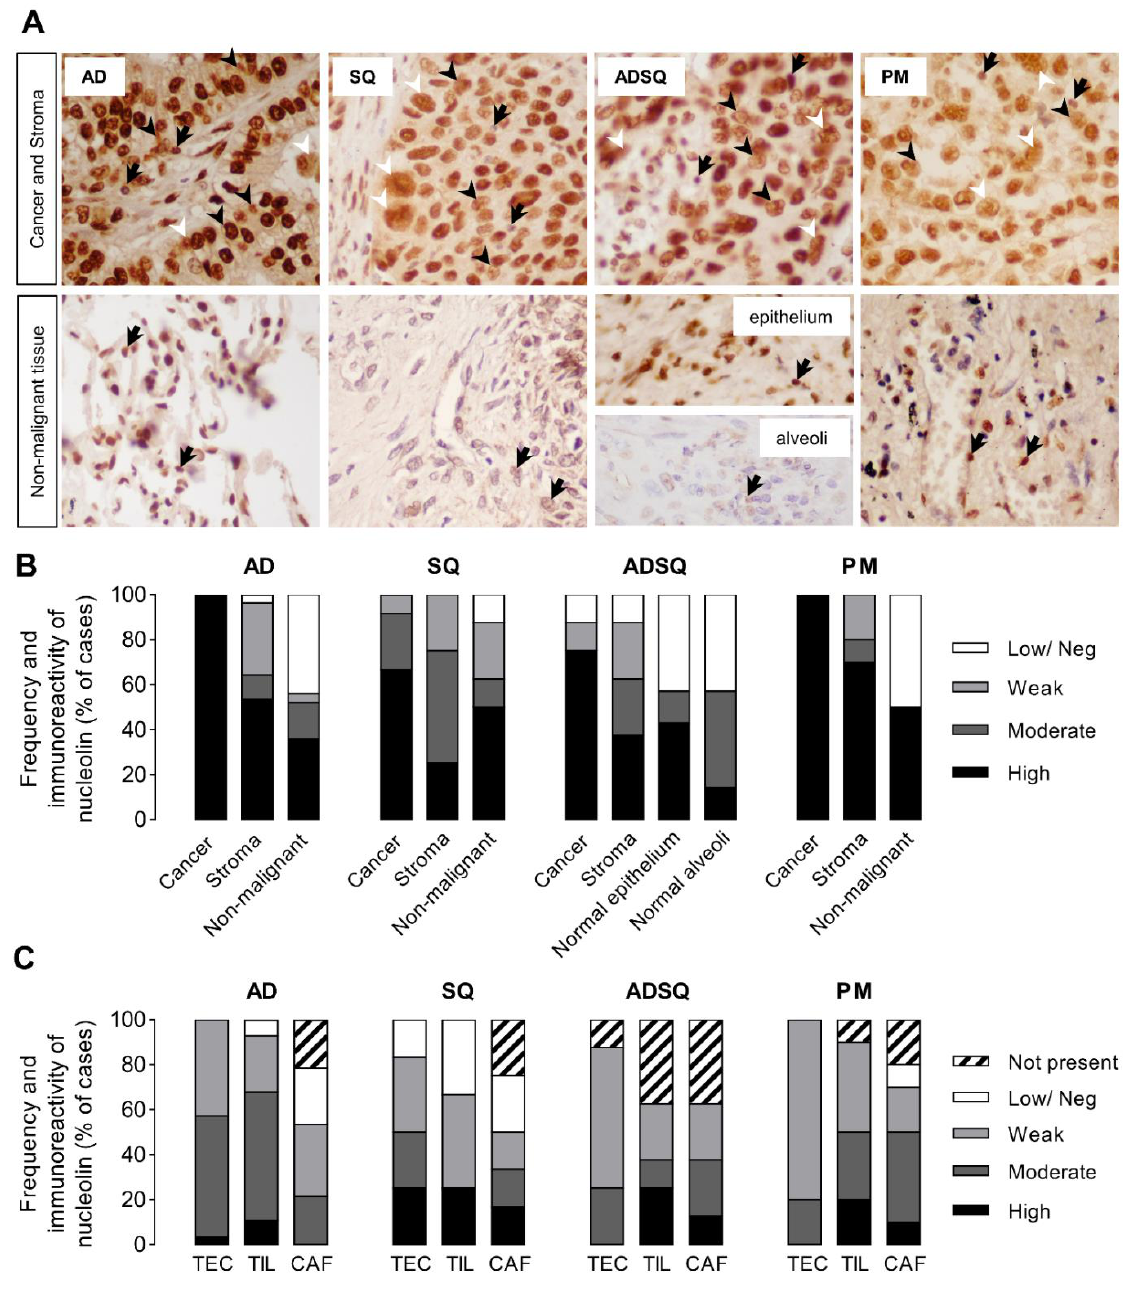
Figure 2. Nucleolin immunoreactivity among four histologically classified human pulmonary carcinomas ( n = 58) and adjacent non-malignant lung tissues. ( A ) Representative images of the tumor cells (×400) and of the adjacent non-malignant tissues (×400) stained for H&E and immunostained for nucleolin. Arrows indicate nucleolar nucleolin; black arrowheads indicate nucleolin spreading throughout the nucleoplasm; white arrowheads indicate extra-nuclear nucleolin. See Supplemen- tary Tables S3 and S4 for complete list of frequencies and global scores of nucleolin immunoreactiv- ities (IR). ( B ) Prevalence of globally scored nucleolin (IR) (see Materials and Methods) as low/nega- tive (white), weak (light gray), moderate (dark gray), and high (dark) in different sub-types of tumor (cancer and stromal) cells (adenocarcinoma, AD; squamous cell carcinoma, SQ; adenosquamous carcinoma, ADSQ; pleomorphic carcinoma, PM) and in the corresponding surrounding non-malig- nant tissues, as well as ( C ) in identifiable stromal cell types, namely tumor endothelial cells (TEC), tumor-infiltrating lymphocytes (TIL), and cancer-associated fusiform cells (CAFs).